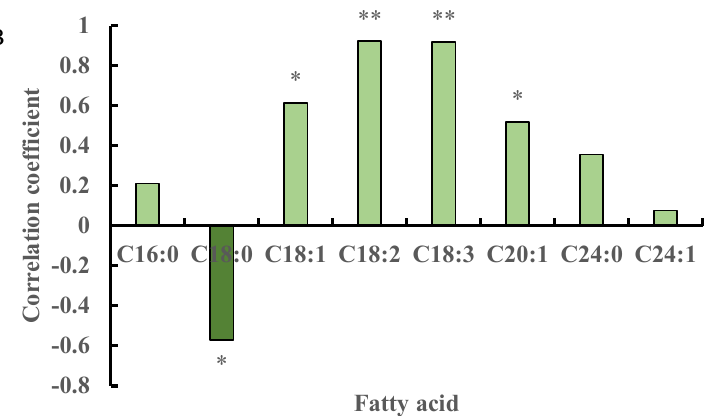
Figure 6. Relation in FA and FADV contents during oolong tea preparation. GM, FO, RO, and DO indicate the green-making step, fixation, rolling, and drying technology of oolong tea, respectively; ( A ) indicates the variation in fatty acids content and their volatile derivative contents differed with the manufacturing technology; and ( B ) indicates the relation between the key FAs and MeJA during the green-making stage of oolong tea. * and ** are the relationships of different FAs with MeJA at p < 0.05 and p < 0.01, respectively.